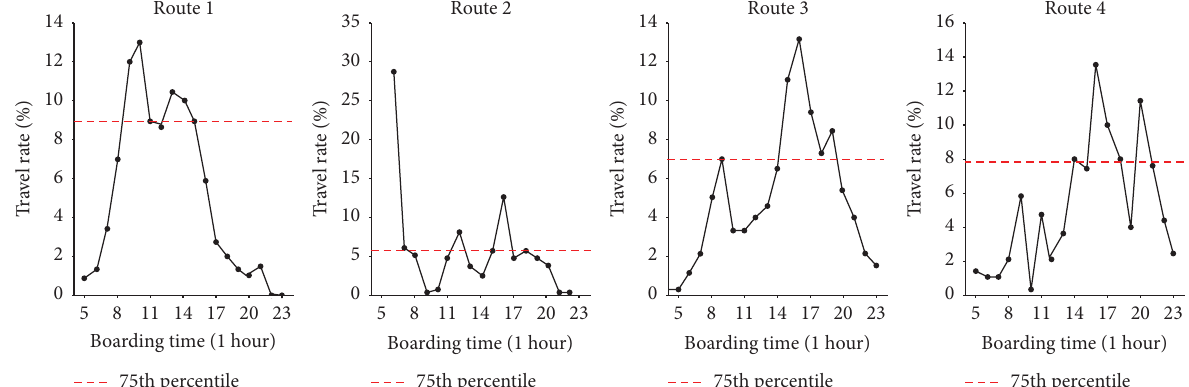
Figure 15: Travel rate by time for < hospital >